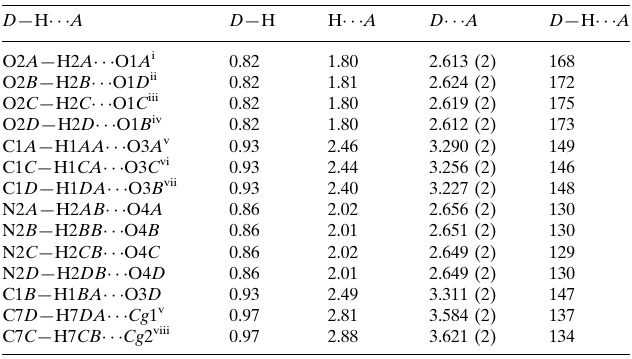
Hydrogen-bond geometry (A˚ , (cid:2)